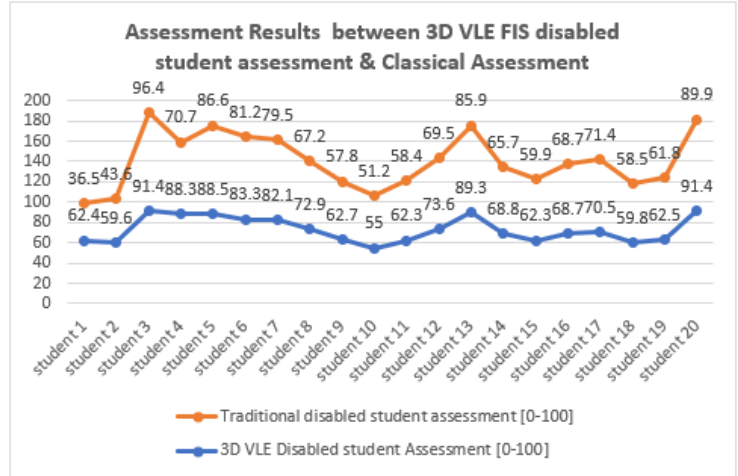
Figure 11. Comparison of Assessment Results between 3D VLE FIS & Classical Assessment .